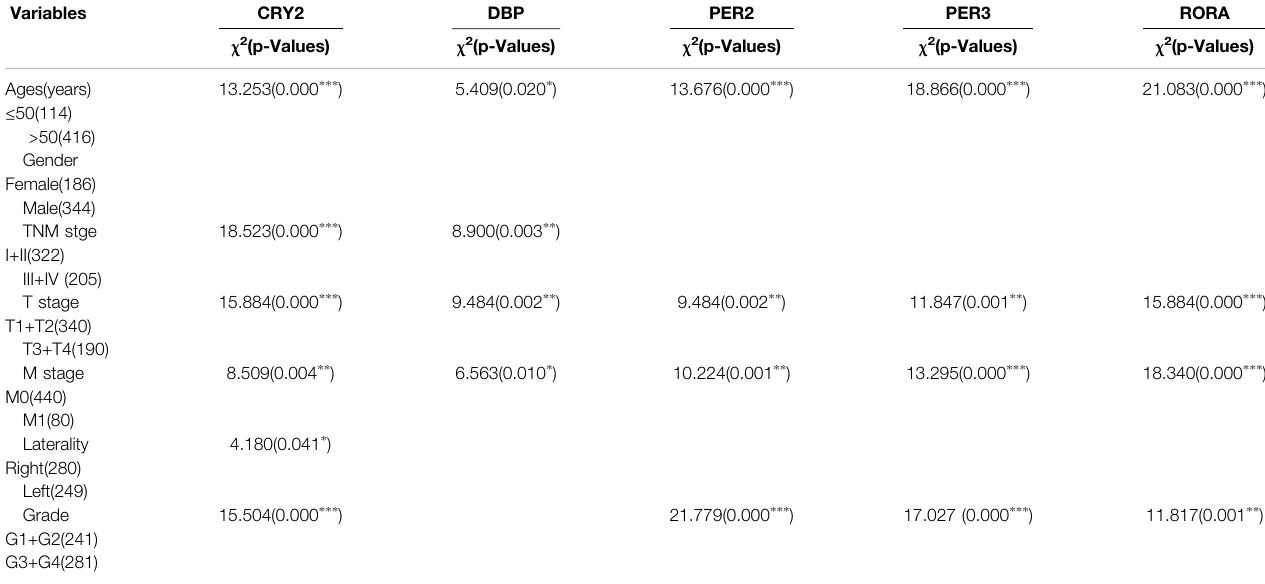
TABLE 1 | The relationship between the fi ve prognostic core clock genes and clinical features in KIRC patients.